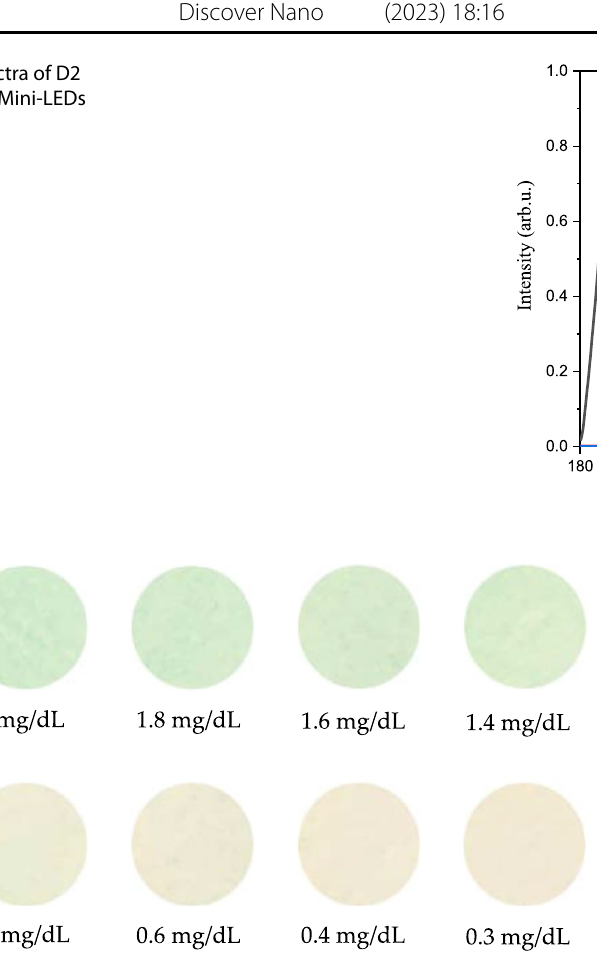
Fig. 6 Color images of test papers with different concentrations of bilirubin while using a D2 lamp as the light